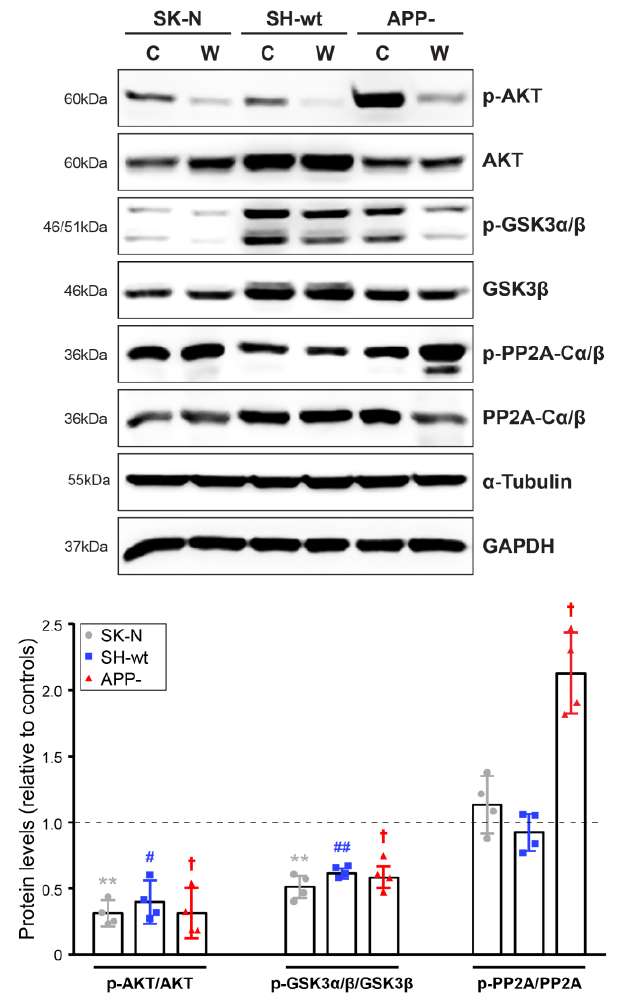
Figure 5. Inhibition of PI3K-AKT by wortmannin deactivates PP2A in SH-SY5Y/APP- cells. Representative immunoblots and quantification of the levels of AKT, GSK3α/β, PP2A - Cα/β and their phosphorylated forms in total protein extracts (40 μg/lane) from SH-SY5Y (SH-wt), SH-SY5Y/APP- (APP-), and SK-N-SH (SK-N) cells after treatment with 100 nM wortmannin (W) for 2 h. GAPDH or α -Tubulin were used as loading controls for normalization. The molecular weights of the proteins are depicted on the left of each blot image. Data are presented as arbitrary units (a.u.) of the mean ± S.D. ratio of the pixel intensity of the phosphorylated bands to the intensity of AKT, GSK3α/β and PP2A- Cα/β total levels in treated cells (W), relative to their respective untreated control cells (C, set at 1, indicated with a dashed line). Dots represent individual data points from four biological replicates. Statistical significance was evaluated by one- way ANOVA followed by Dunnett’s multiple comparison test. “*”is used to depict statistically si gnificant differences between control and treated SK-N cells (** p < 0.01), # between control and treated SH-wt cells (# p < 0.05, ## p < 0 .01), while † shows statistically significant differences between control and treated APP- cells († p < 0.05). AKT, Alternative appellation for Protein kinase B; GSK3, Glycogen synthase kinase-3; PP2A, Protein phosphatase 2A-C alpha/beta; GAPDH, Glyceraldehyde 3-phosphate dehydrogenase.